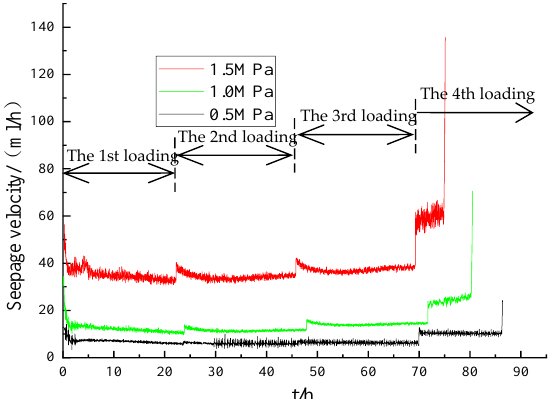
Figure 11. Seepage velocity – time curve in the whole process.